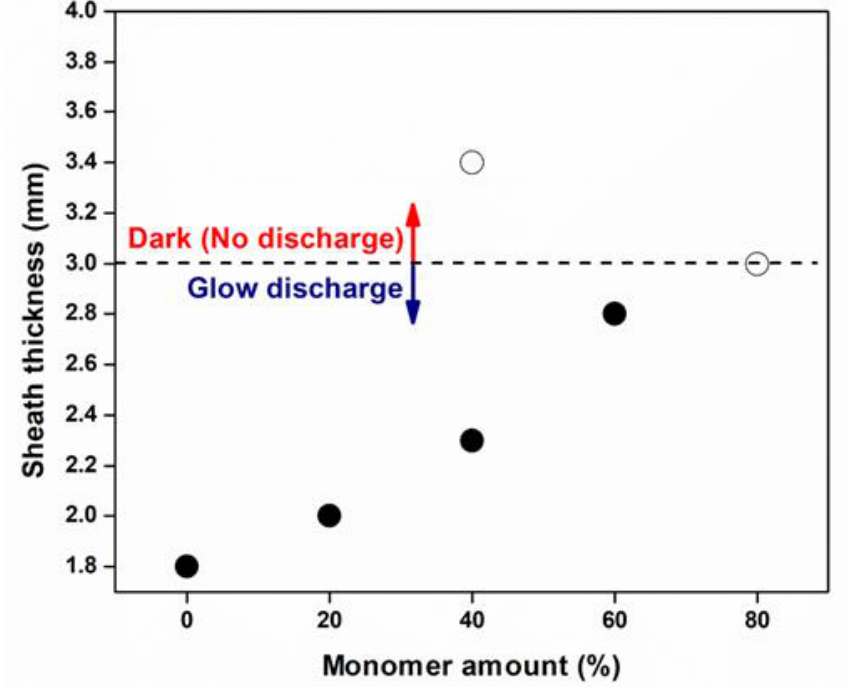
Figure 6. Sheath thickness with variation in monomer percentage and with the possibility of losing glow discharge inside the tube. The unit of monomer amount indicates the volume percentage. Note: The conditions with monomer amount at 40%, power at 50 W, and pressure at 0.4 torr (sheath thickness = 3.42 mm) will not initiate a glow discharge inside the tube.